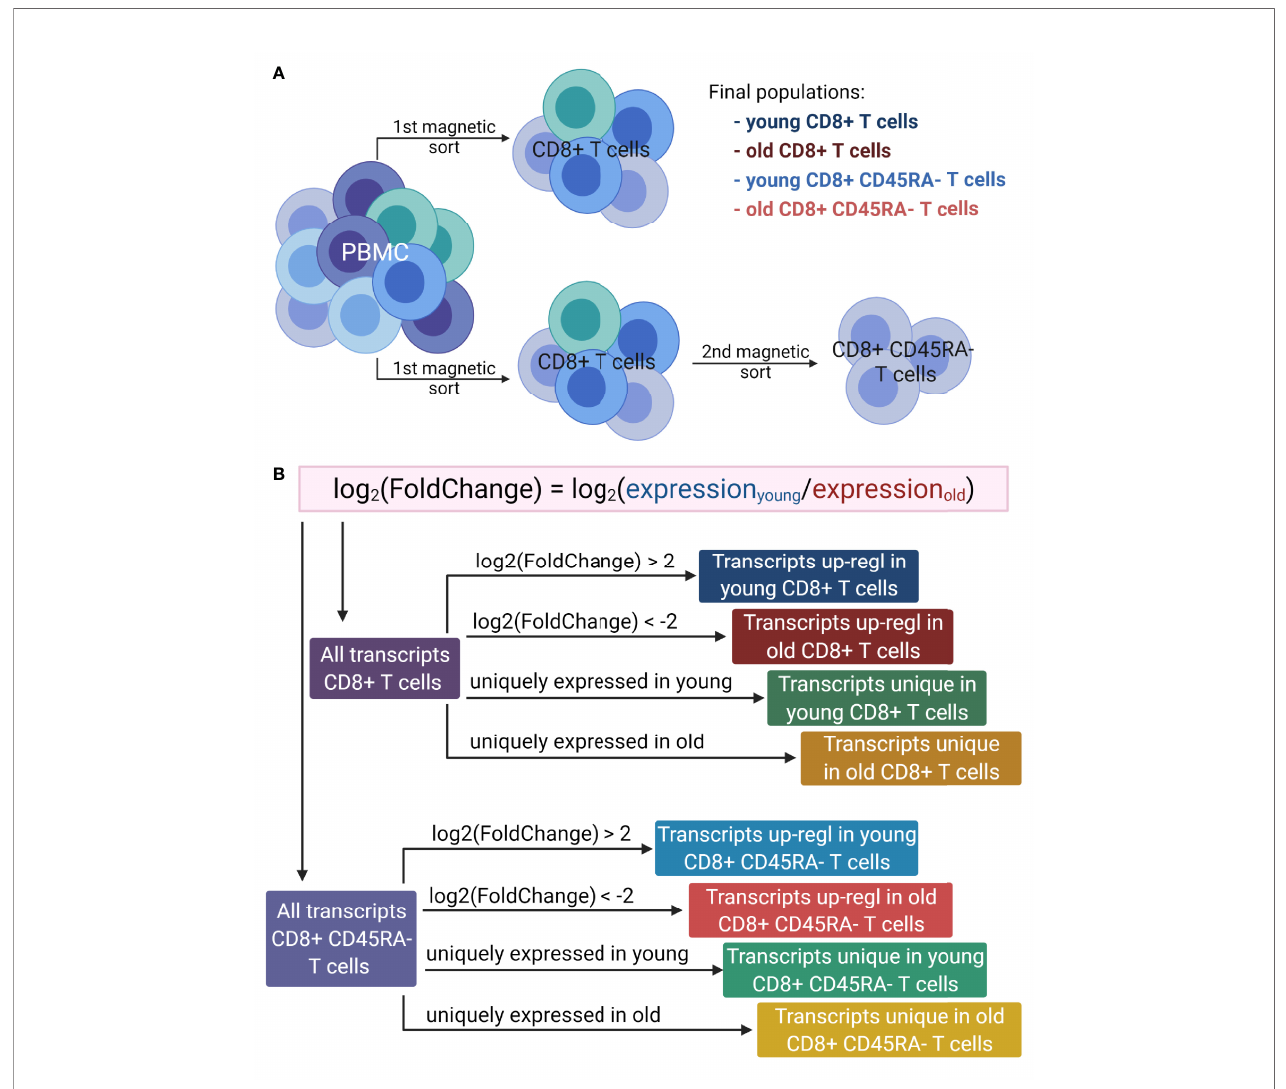
FIGURE 1 | Overview of the work fl ow. (A) . Generation of T cell populations used for RNA sequencing. PBMC were isolated from multiple donors of two age groups: young (<30 years) and old (>60 years). The total CD8 + T cells were magnetically sorted from the PBMC directly, and to isolate the CD8 + CD45RA - memory T cells, the total CD8 + T cells were magnetically sorted from the PBMC and then the memory T cells were isolated from the total CD8 + T cells. This protocol was applied for both age groups. (B) . Lists of transcripts used for GO term enrichment. For both T cell populations, the log 2 (FoldChange) of gene expression was calculated as the expression of T cells of young versus that of the old donors. The transcripts up-regulated in either young or old donors were determined based on the log 2 (FoldChange) value. Two additional lists were generated for each cell population, based on the absence of expression for one of the age groups. Up-regl = up- regulated. The fi gure was prepared with